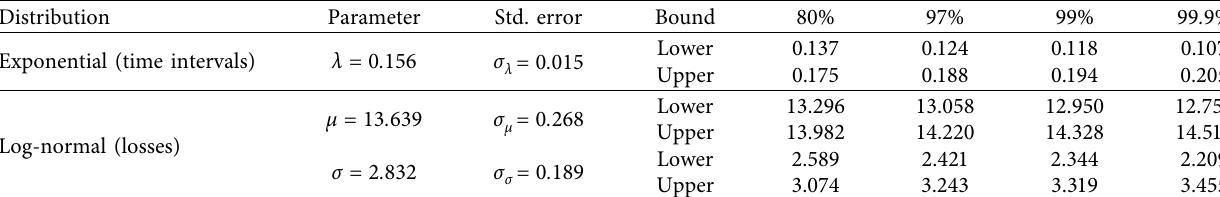
Figure 8: Probability distribution functions selected for loss ftting (logarithmic scale). Table 5: Confdence interval for estimates.